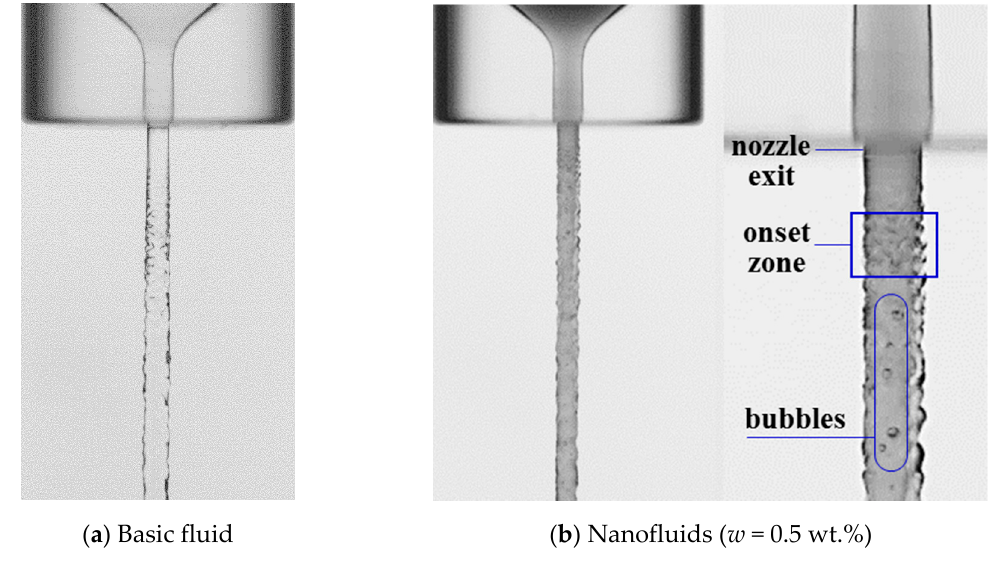
Figure 15. Comparison of cavitation in the liquid column of a round jet at Re j = 17260.